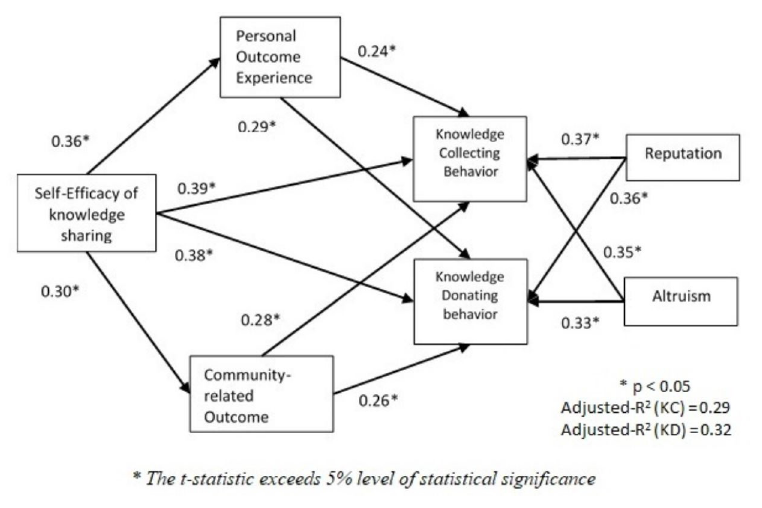
Fig 3. Structural